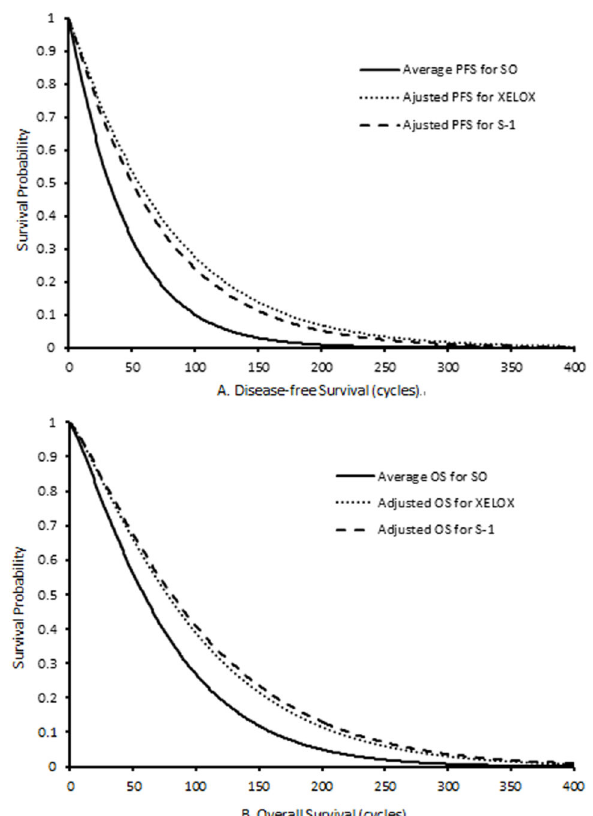
Figure 2. The Weibull curves of (A) disease-free survival and (B) overall survival. doi: